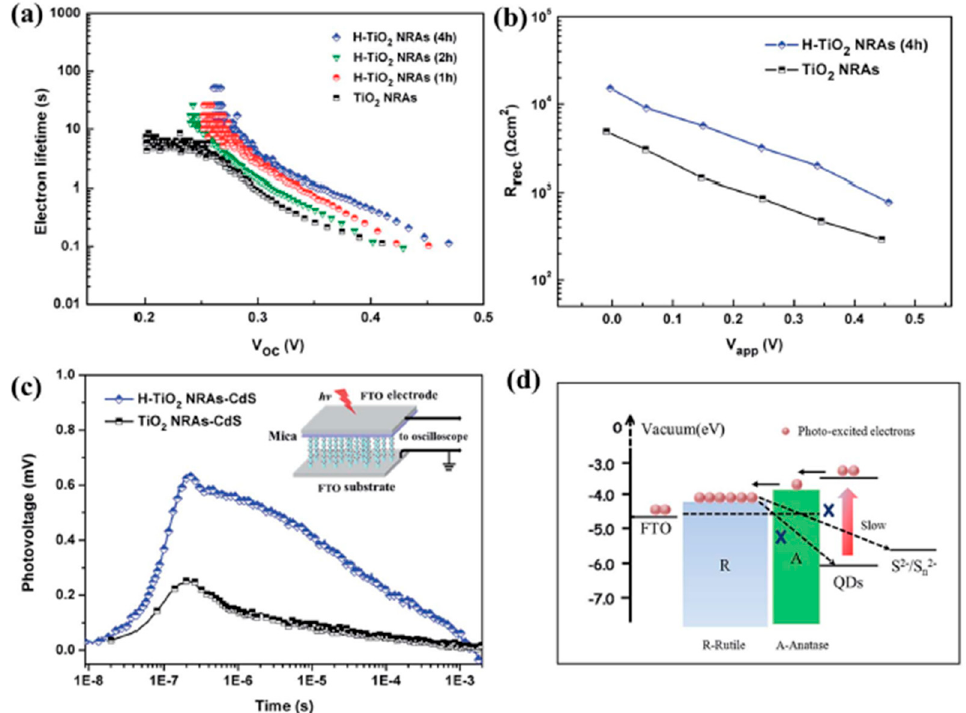
Figure 23. ( a ) Electron lifetime as a function of Voc for TiO2 NRA and H–TiO 2 NRA electrodes with various reaction times. ( b ) Recombination resistance (Rrec) of the QDSCs made from TiO 2 NRAs and H-TiO 2 NRAs at various forward biases in the dark. ( c ) Transient photovoltage responses of CdS–TiO 2 NRAs and CdS–H-TiO2 NRAs. The wavelength of the laser pulse was 532 nm. Inset: schematic setup of TPV measurements. ( d ) Schematic configuration for our device showing the interfacial charge transfer and recombination processes [138]. Copyright 2015 The Royal Society of Chemistry.